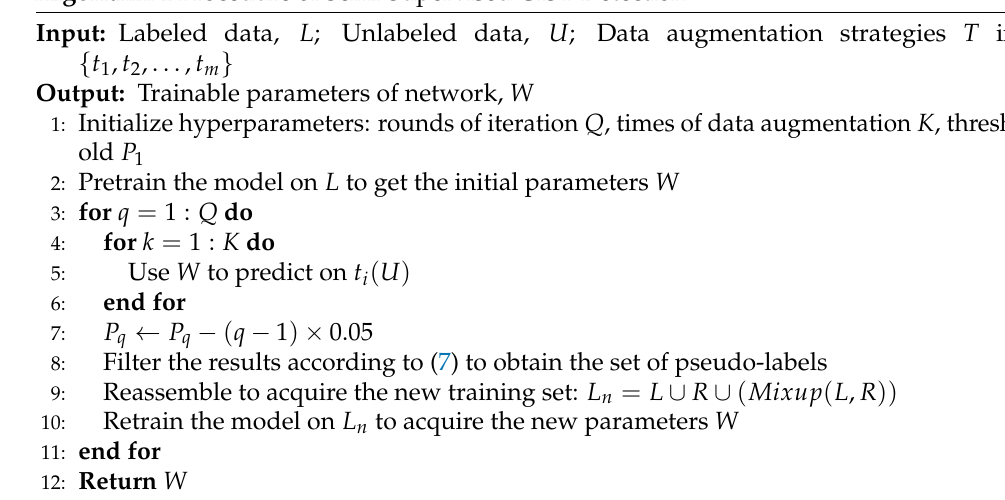
Algorithm 1 Procedure of Semi-Supervised GIST